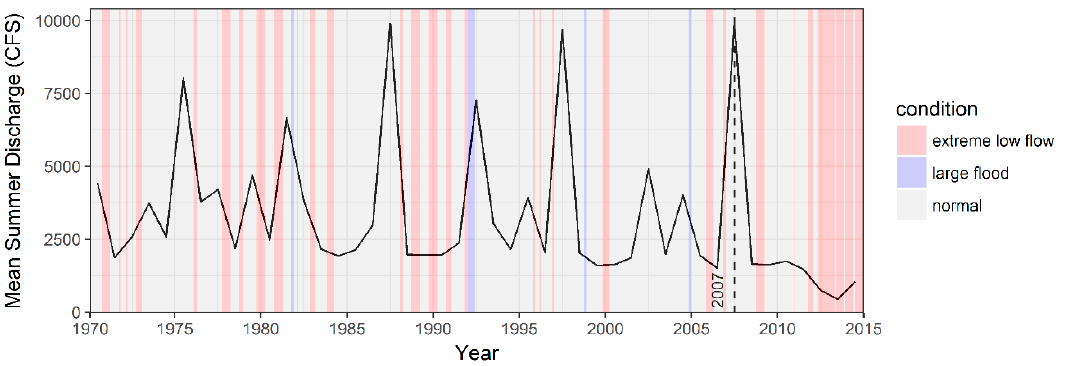
Figure 4. Change point for river characteristics: Mean annual summer discharge (CFS) on the Colorado River near Columbus, Texas, from 1970 to 2014, overlaid against IHA calculations for periods of extreme low flow, large floods, and normal conditions.